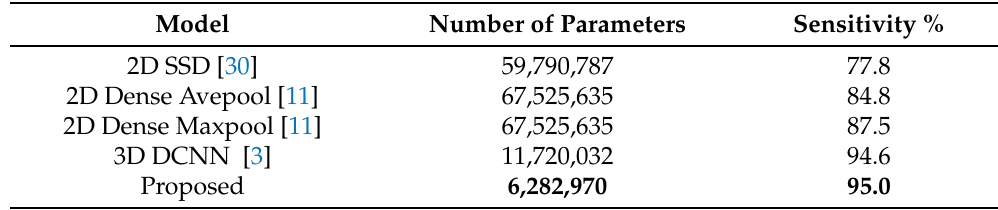
Figure 6. Visualization of detection results and nodule ground truths. Table 3. Comparison results of the number of parameters and sensitivity in different